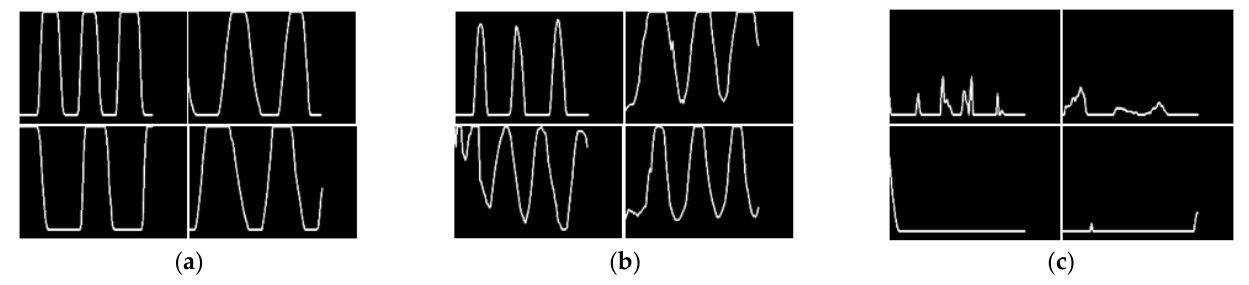
Figure 6. Three categories of waveforms: ( a ) complete, ( b ) no-complete, and ( c ) no-movement. Table 8. The distribution of training and testing data in database W.